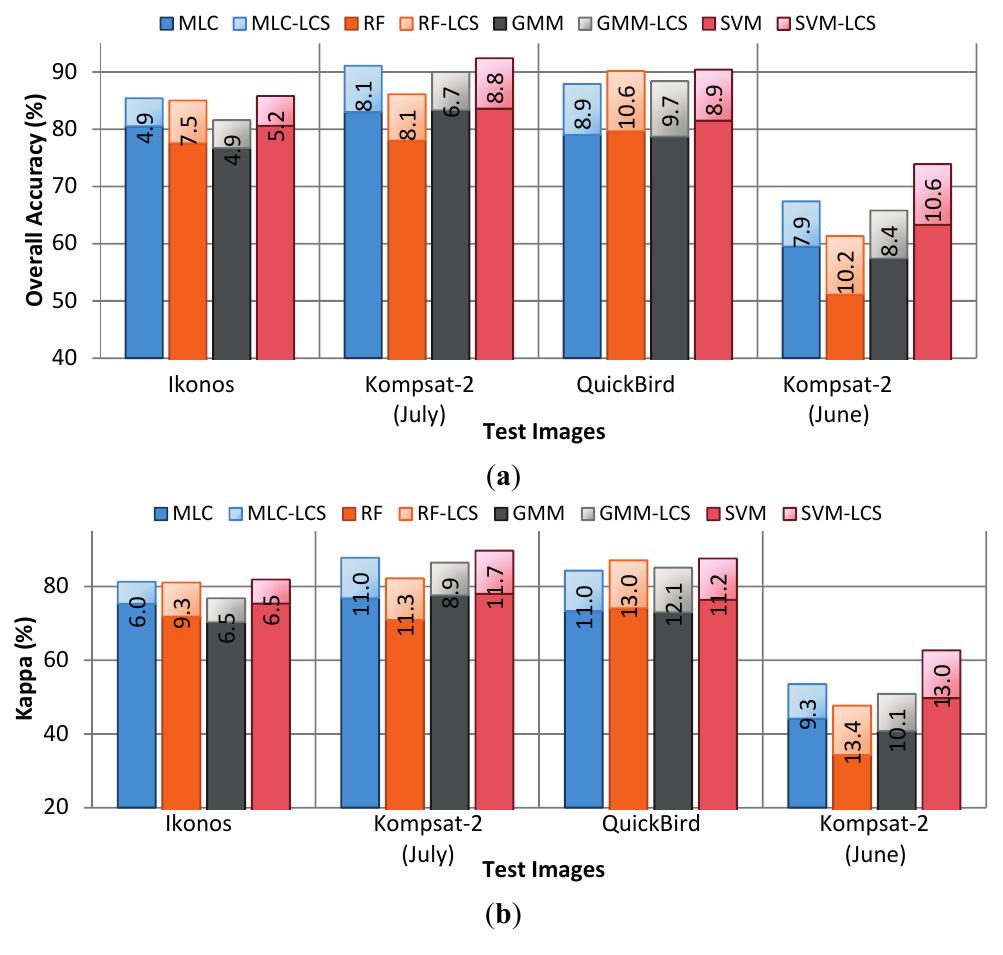
Figure 4. Performance improvements after CRF contrast smoothing. ( a ) Overall accuracies, and ( b ) kappa